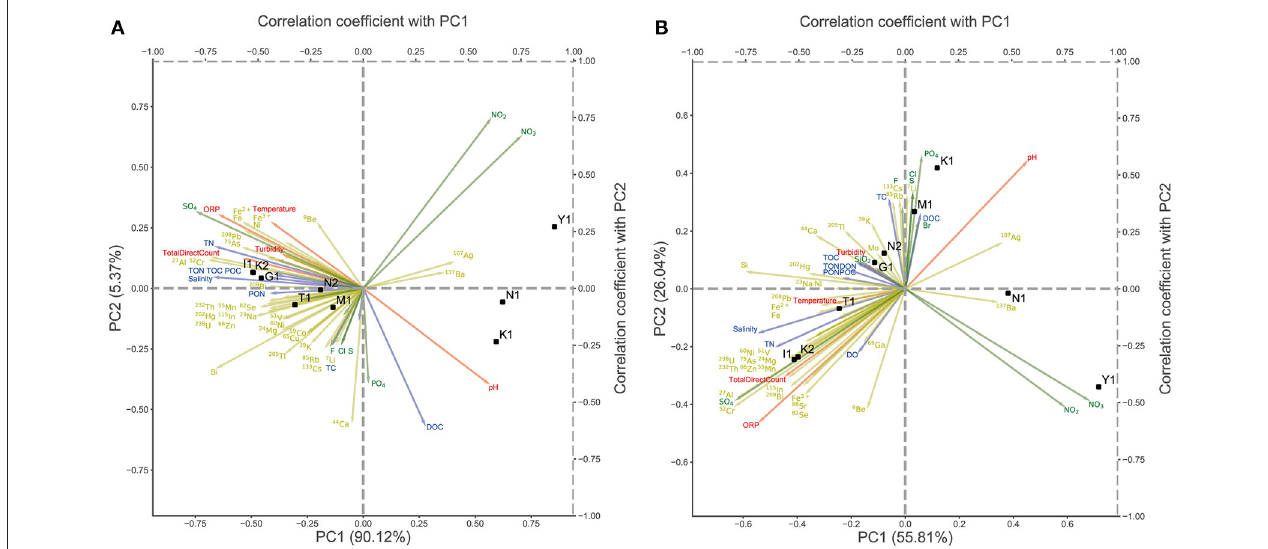
FIGURE 3 | Principal component analysis (PCA) of the relative abundance of each sample across nine sites. The arrows represent the correlation coefficient between the principal component scores and each environmental parameter. The yellow arrows represent cations, the green arrows represent anions, the blue arrows represent water quality and the red arrows represent physical properties. (A) PCA of the relative abundance at phylum level. (B) PCA of the relative abundance at detailed taxonomic level. ( Supplementary Tables 6,7 ). The gene (K01906_bioW)